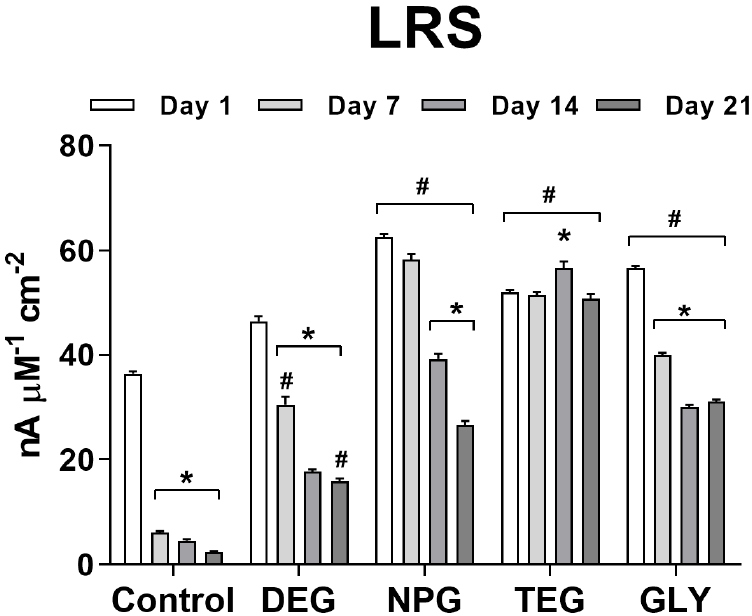
Figure 5. Bar plot of the variation of LRS for different biosensor designs (n = 4): Pt c /PPD/PEI(1%) 2 /GlutOx 5 /Glycol(0.1%). Pt c : Pt cylinder 1 mm long; GlutOx: L-glutamate oxidase; PPD: ortho-phenylenediamine polymer; PEI: polyethyleneimine, DEG: diethylene glycol, NPG: neopentyl glycol, TEG: triethylen glycol, GLY: glycerol. The subscript number represents the number of dips and in brackets, the concentration of the glycol. Values are expressed as mean ± SEM. * p < 0.001 vs. Day 1 of the respective group. # p < 0.001 vs. control design.